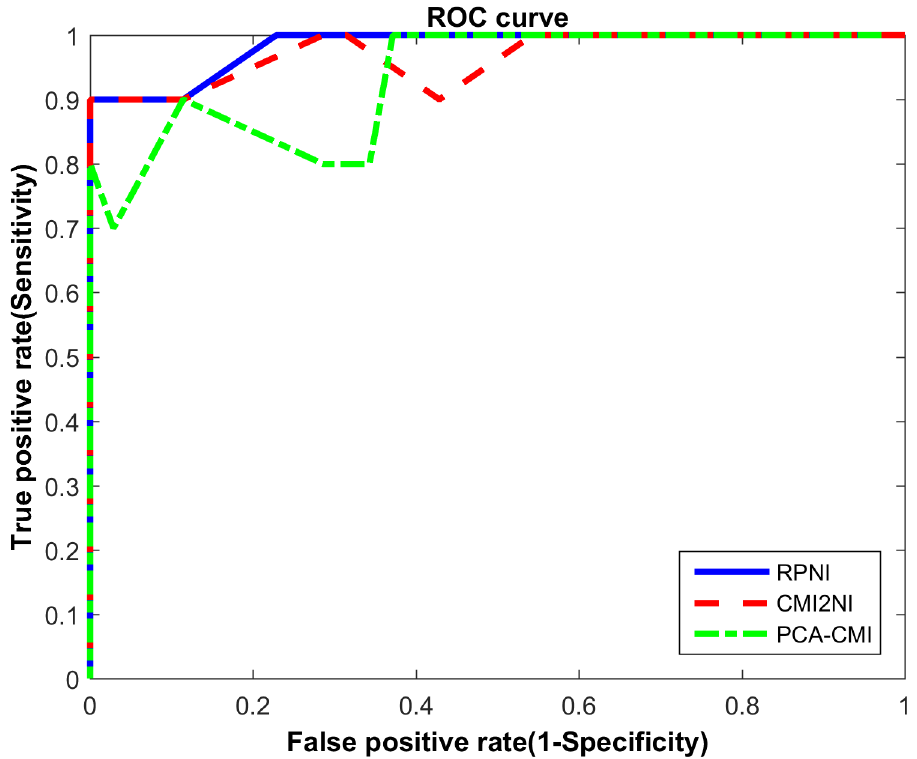
Fig 3. ROC curves generated using several methods including RPNI, CMI2NI, PCA-CMI on DREAM3 challenge Yeast1 dataset in size 10. The blue solid line is the ROC curve of RPNI. The AUC value reaches